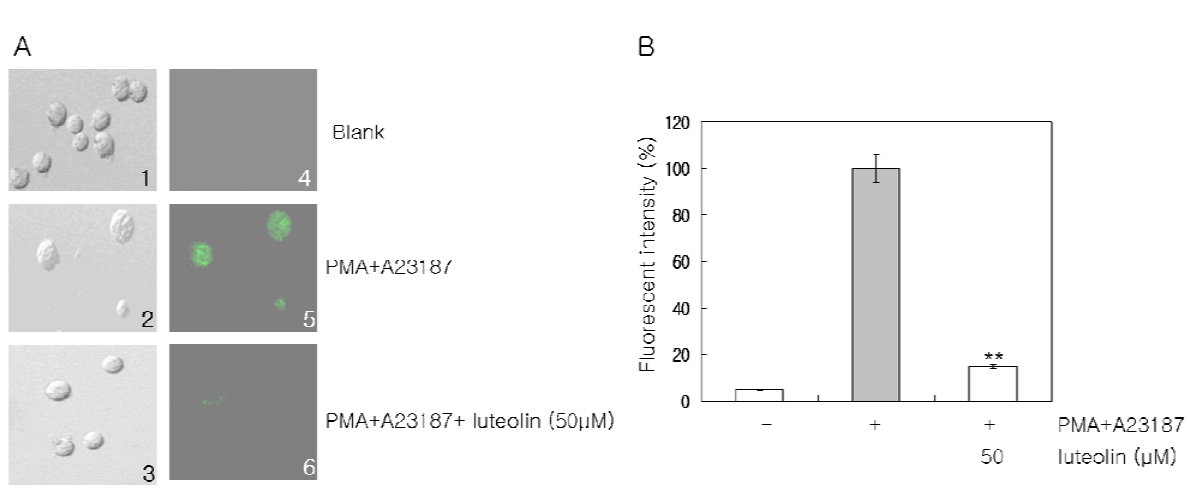
Figure 4. Effect of luteolin on intracellular calcium levels.